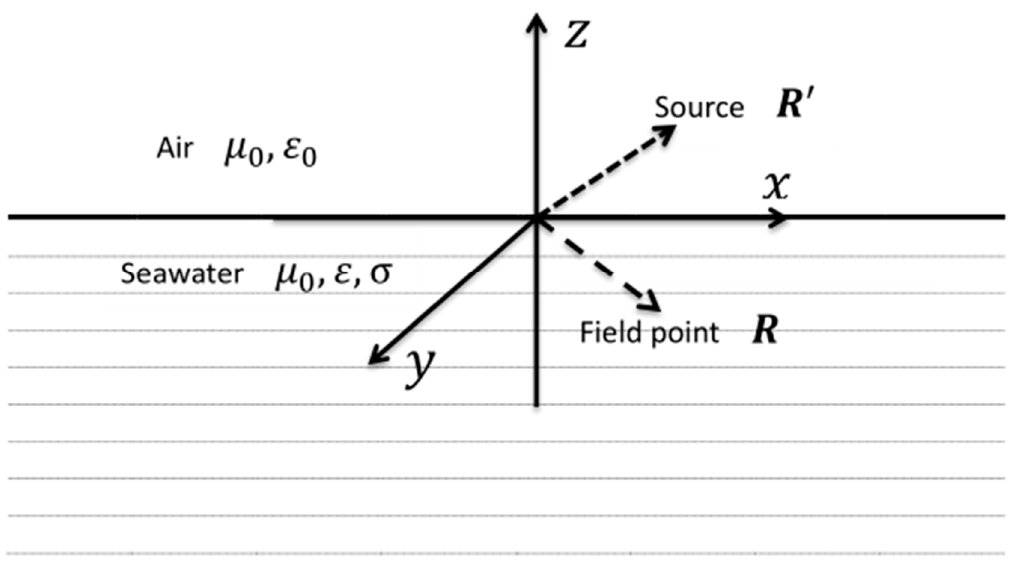
Figure 2. Air-Seawater two-layer model in space rectangular coordinate system.